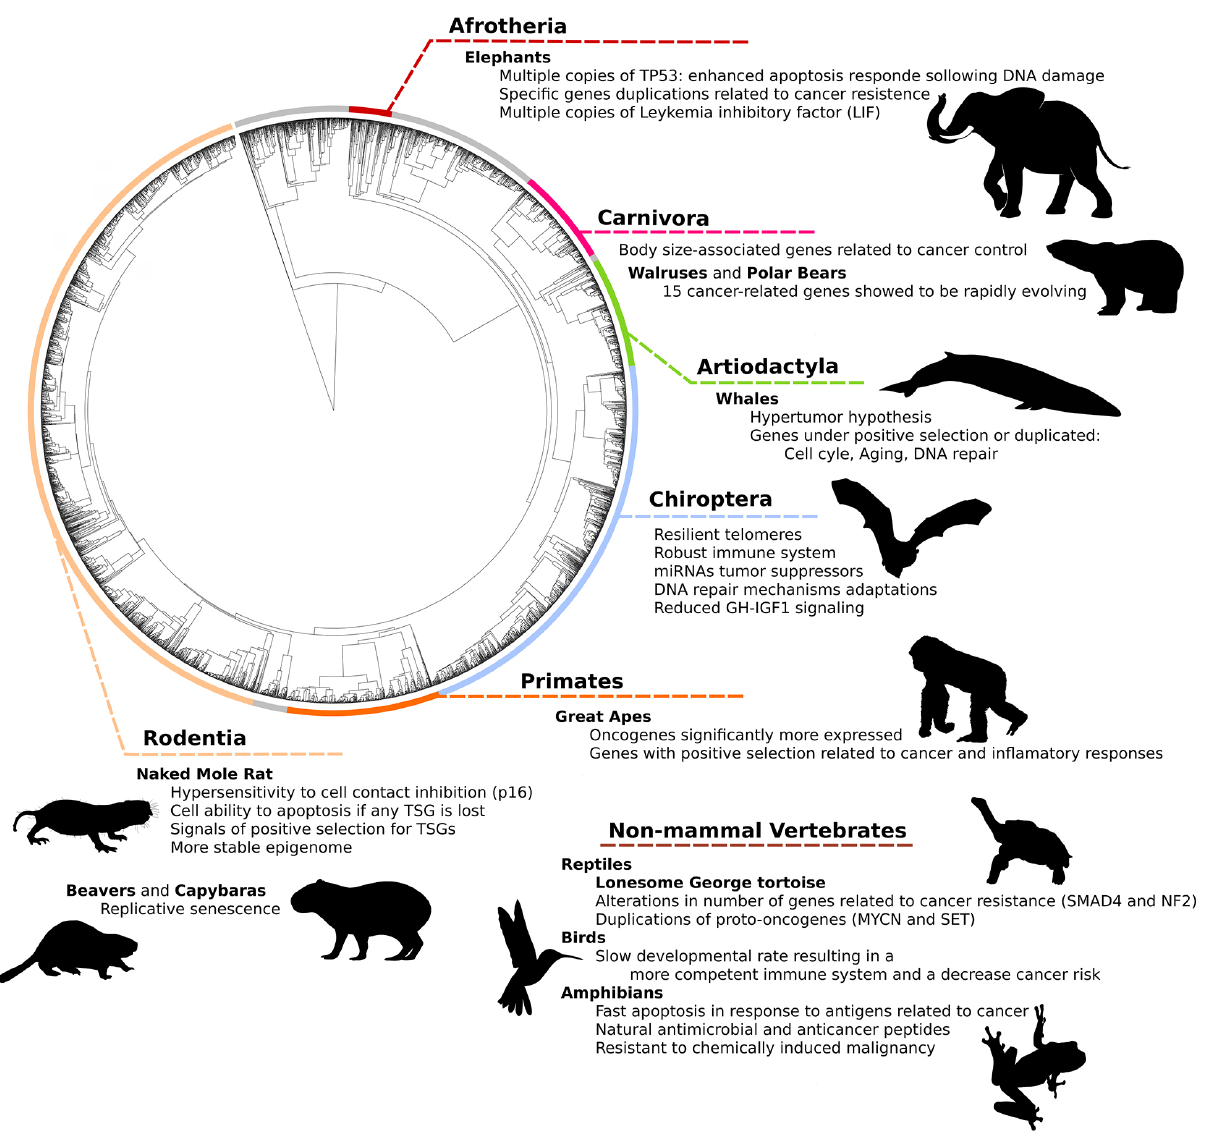
Figure 1 – Summary of the main genetic mechanisms related to cancer resistance in vertebrate